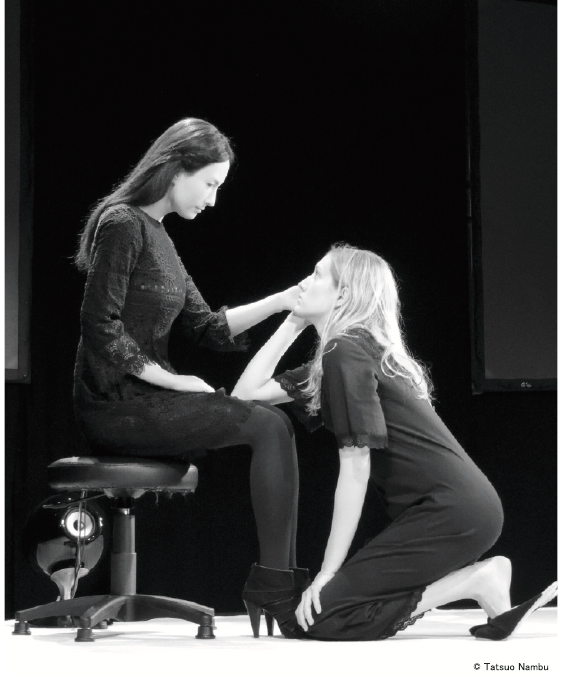
Figure 1. Android theatre